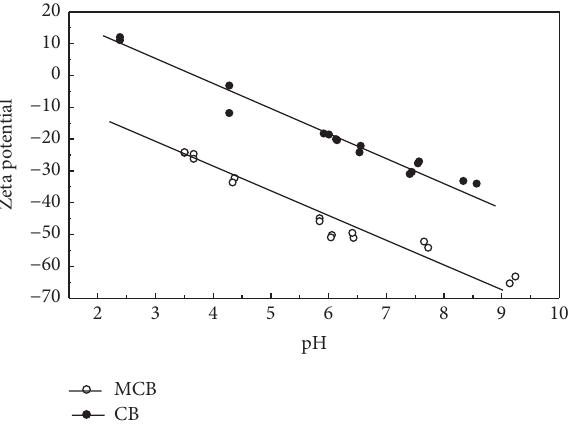
Figure 1: Zeta potential of MCB and CB.